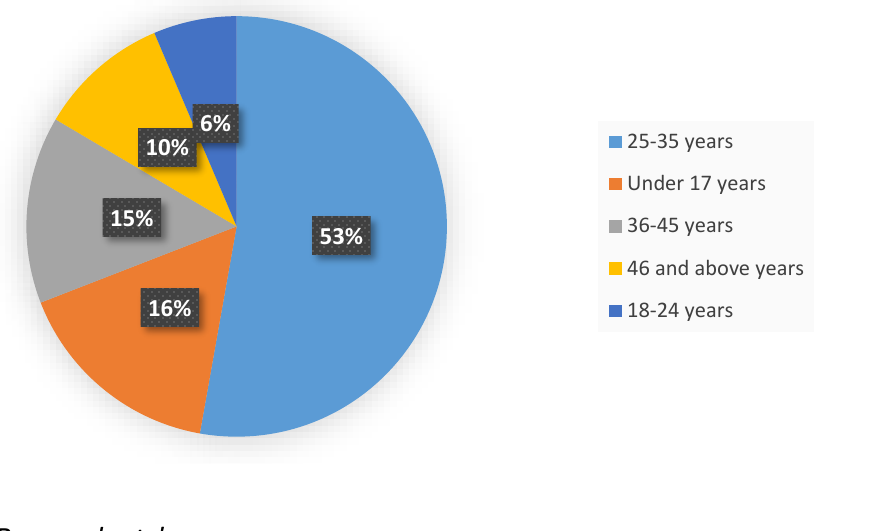
Figure 2. Respondents' age The results from item 3 which asked respondents to indicate the number of courses they had taken on-line indicated that 189 (45.3%) of the respondents had done very few on-line courses, 77 (18.5%) indicated that they had done few on-line courses, 41 (9.8%) had done an average number of courses on-line, 22 (5.3%) indicated that they had done a good number of on-line courses while 88 (21.1%) of the respondents did not indicate the number of courses they had done online. A summary of the findings is provided in Figure 3.